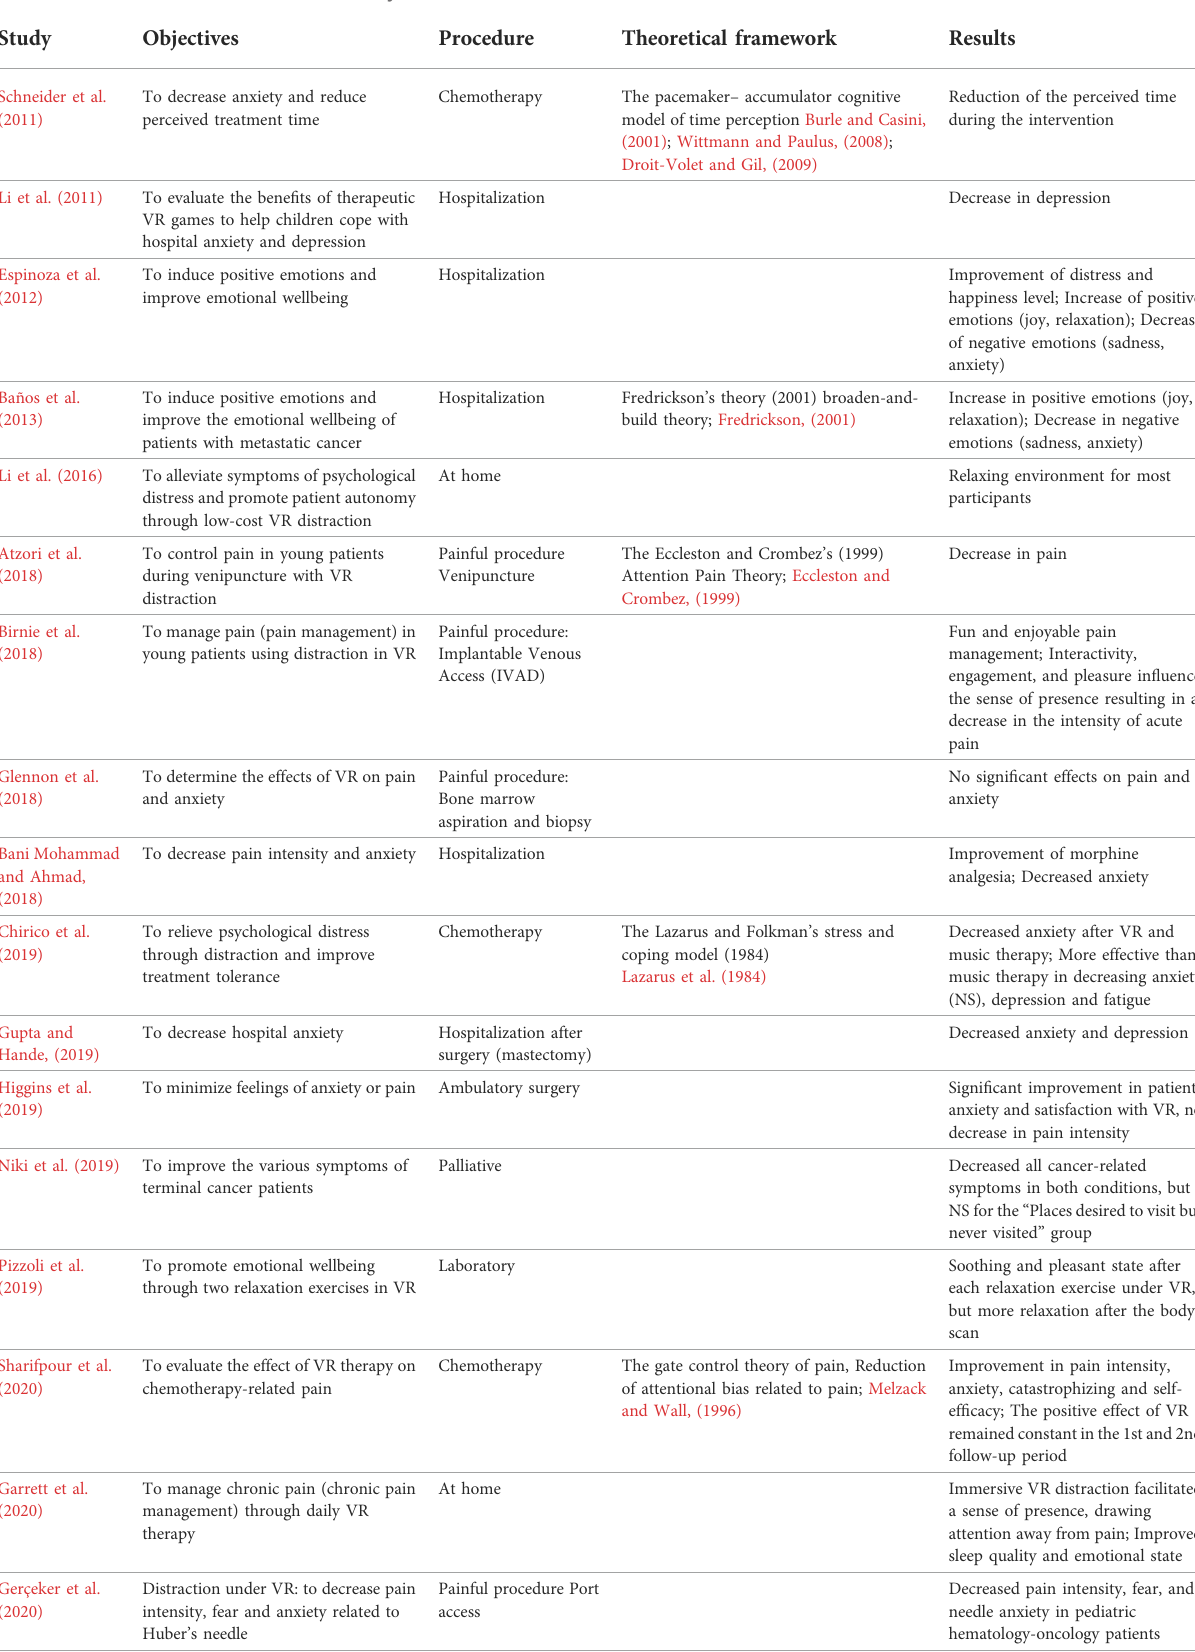
TABLE 1 Studies on the bene fi ts of virtual